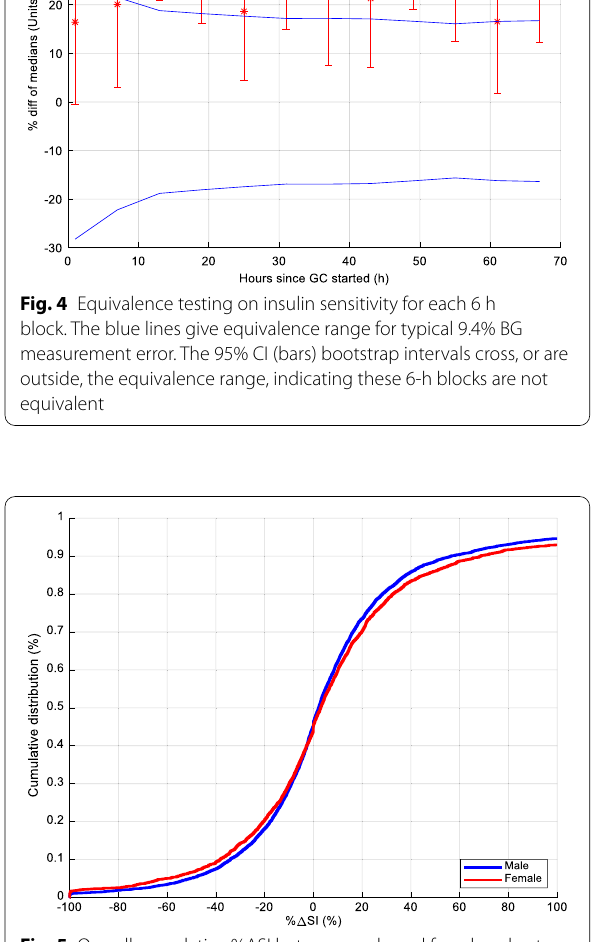
Fig. 5 Overall cumulative %ΔSI between male and female cohorts